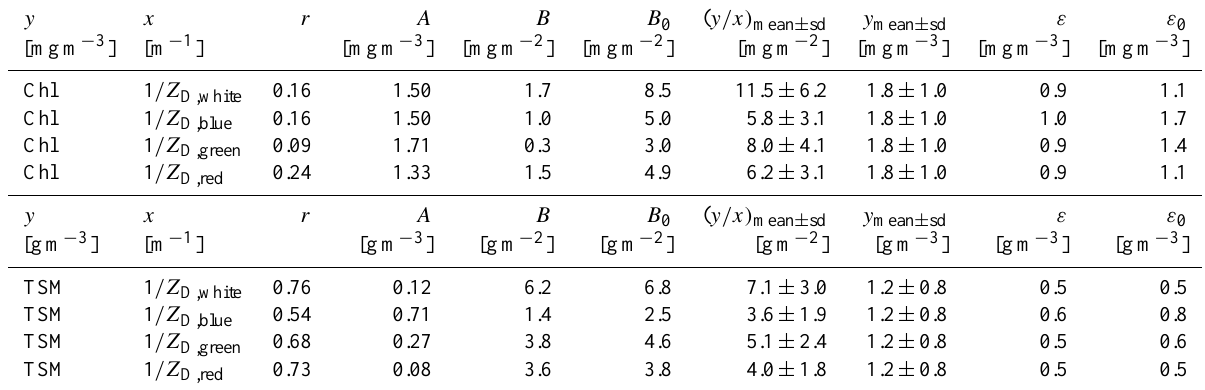
Table 9. Relationships of the forms y = A + Bx and y = B 0 x obtained by correlation analysis of chlorophyll a (Chl), total suspended material (TSM) and inverse Secchi depths (1 /Z D ) observed with the open eye and with blue, green and red glass filters. The concentrations of Chl and TSM are averages over the depth range 0– Z D,white , and r is the correlation coefficient. The error ε is the root mean square of the